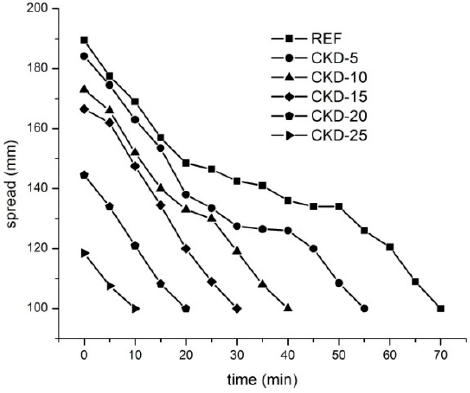
Figure 1. Compressive ( a ) and flexural ( b ) strengths development of alkali-activated mortars with different amounts of CKD.